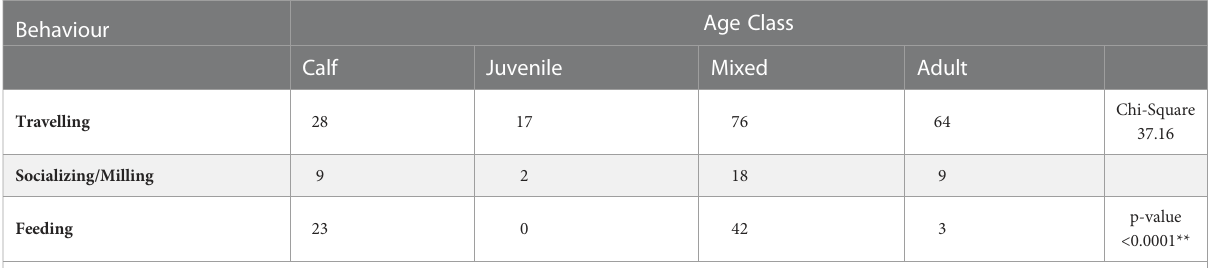
TABLE 7 Comparison of observed frequency of beluga behaviour in the presence of vessels by age